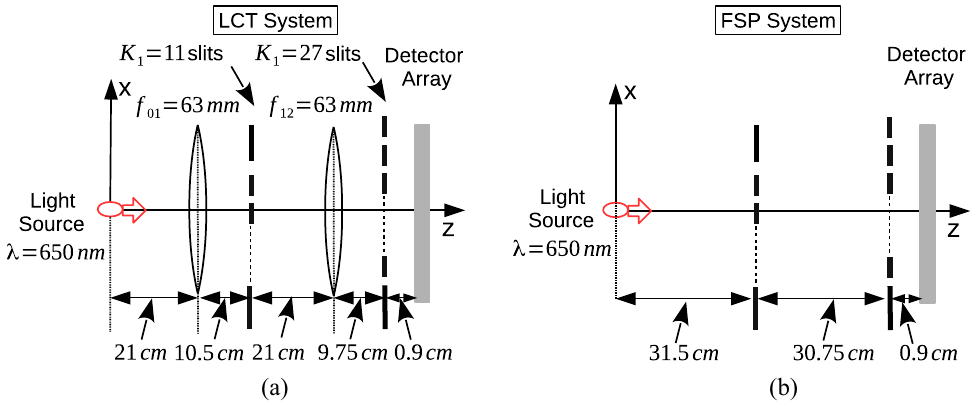
650 nm, = 11 and K 2 27 , respectively, and specific set-up of ( a ) = =